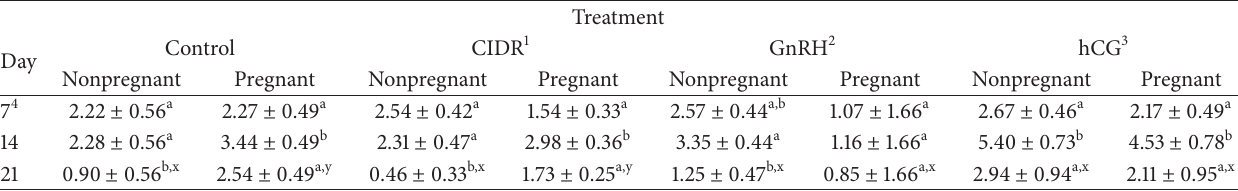
Table 1: LSMeans and standard errors for concentrations of progesterone (ng/mL) in nonpregnant and pregnant cows within treatments. Treatment